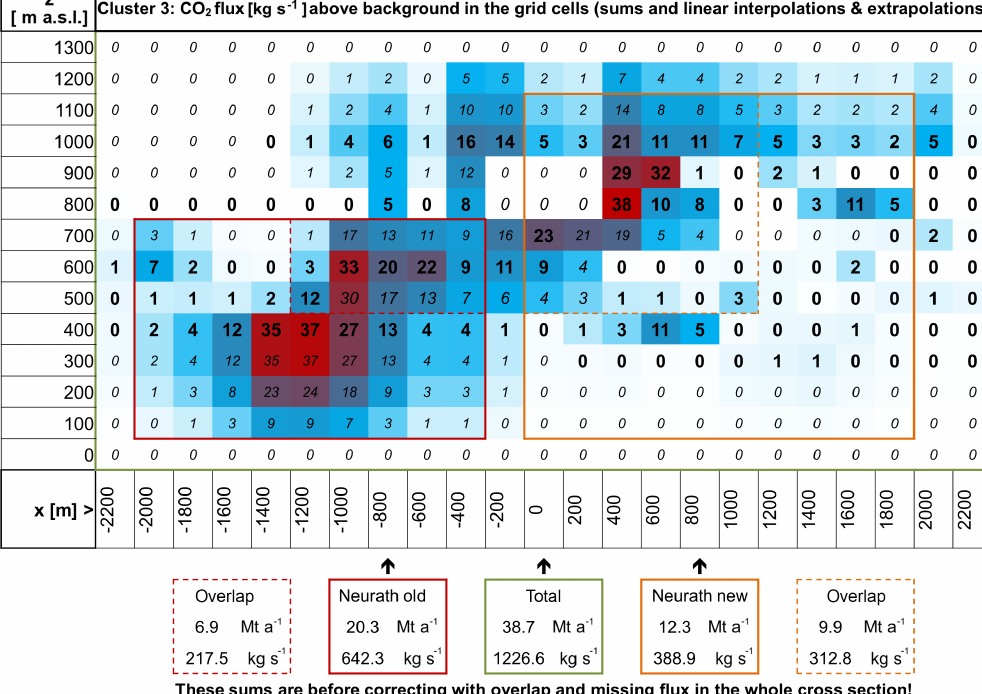
Figure 8. The same as Figs. 4 and 7, on the cross section downwind of the total cluster without Frimmersdorf (S4). The two domains and the overlap with the plume from Niederaußem (S1) in the background were used to separate the almost collinear plumes of Niederaußem and Neurath old (S2) and new (S3). The uncertainty was quantified by varying the parameters in the overlapping cells between 20 and 80% (background from Niederaußem versus Neurath old and